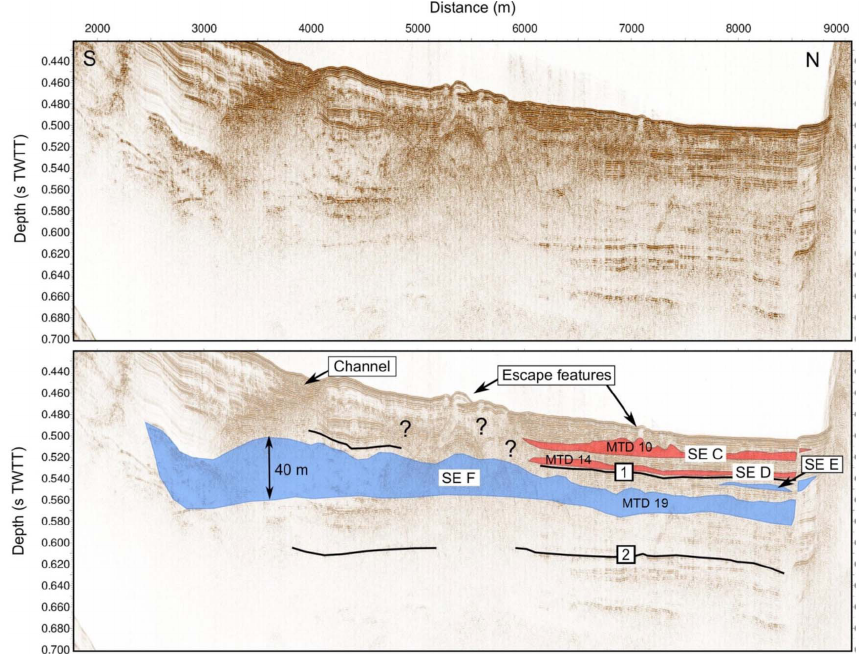
Figure 4. S–N sparker seismic profile showing the mass transport deposits imaged in the Delphic Plateau basin. Question marks highlight units of remobilized sediments that are difficult to localize in the stratigraphic framework. See the location of the profile in Fig.